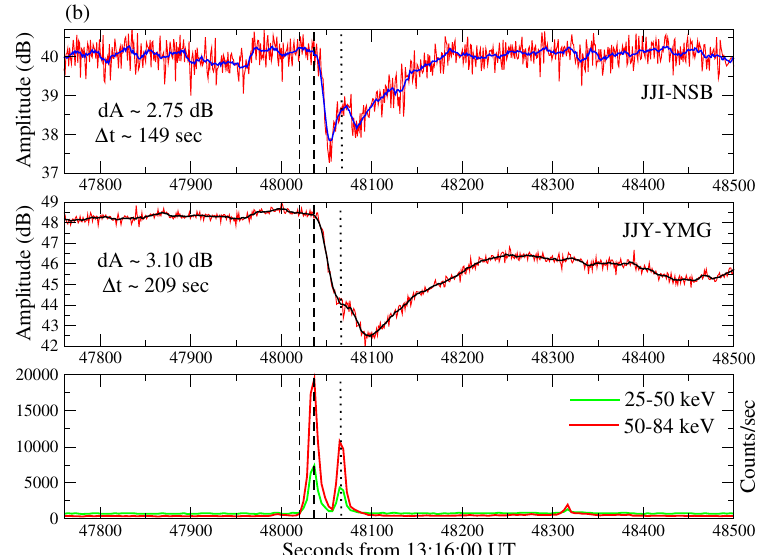
Figure 2. Nighttime VLF/LF signal perturbations associated with the GRB220910A in the Japanese UEC VLF network for long propagation paths ( a ), and short propagation paths ( b ). The lowest panels of ( a , b ) show the light curve of the GRB in two energy bands 25–50 keV (green) and 50–84 keV (red). The two vertical dashed lines indicate the event trigger and peak flux times. The third dotted line indicates the peak flux time of the subsequent trigger. Blue curves in the VLF/LF are the seven points running mean